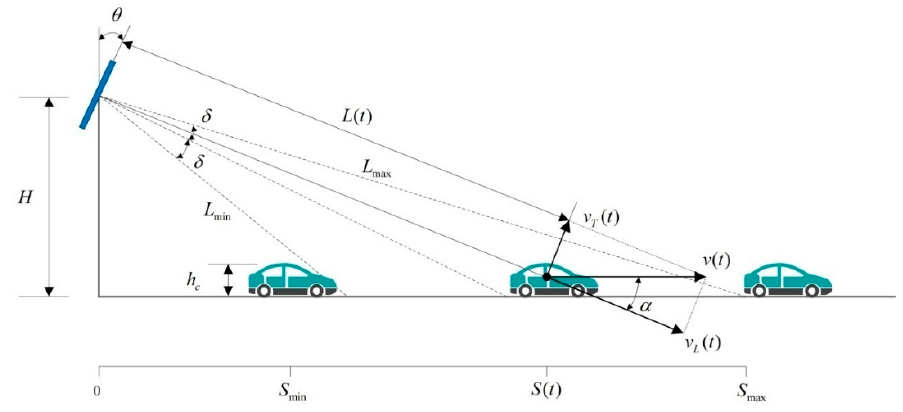
Figure 2. Distance measurement of vehicles.